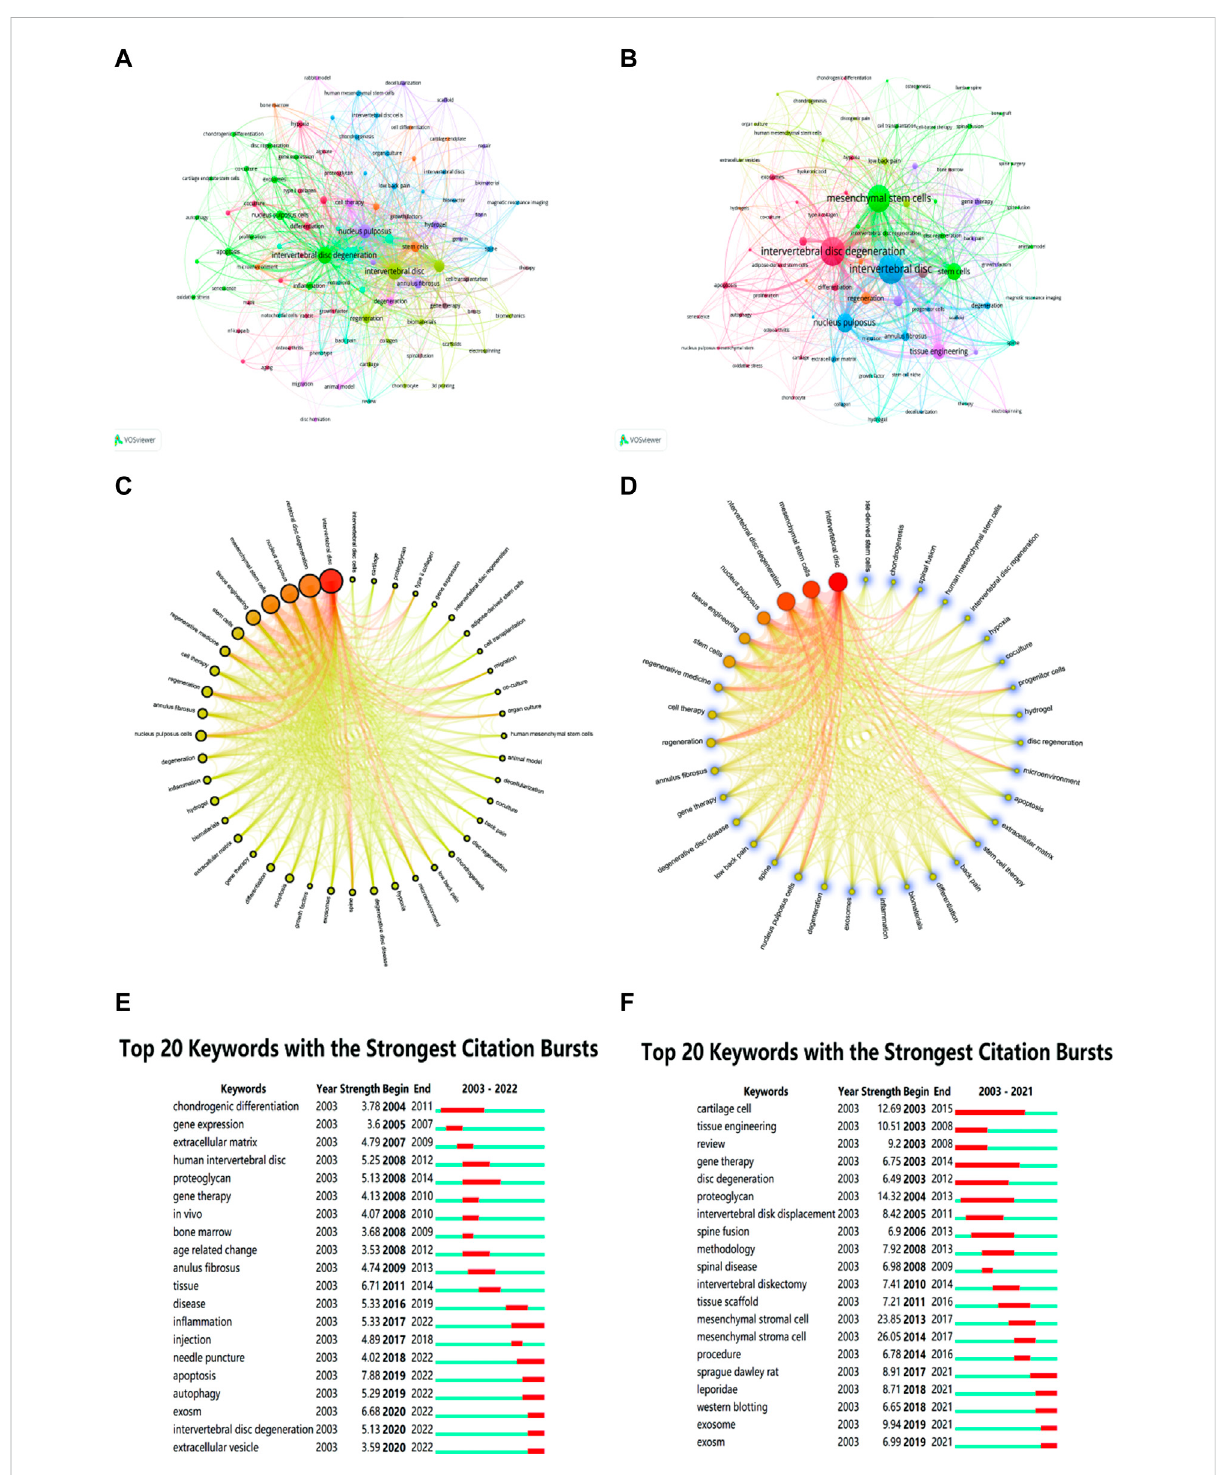
FIGURE 10 Keyword clustering, total link strength and strongest citation bursts analysis. The keywords clustering network visualization analysis in WOSCC (A) and Scopus (B) . In WOSCC and Scopus, main author keywords all formed 9 clusters. The circular diagrams (C,D) were used to highlight the number of major co-occurring keywords and the total link strength. The greater the occurrence frequency, the larger the node, the higher the total link strength, the redder the segment, and the larger the link between the two, the thicker and deeper the line. The top 20 keywords with the strongest citation bursts in WOSCC (E) and Scopus (F) . The color indicated the various frequent keywords (red represented frequent and green represented